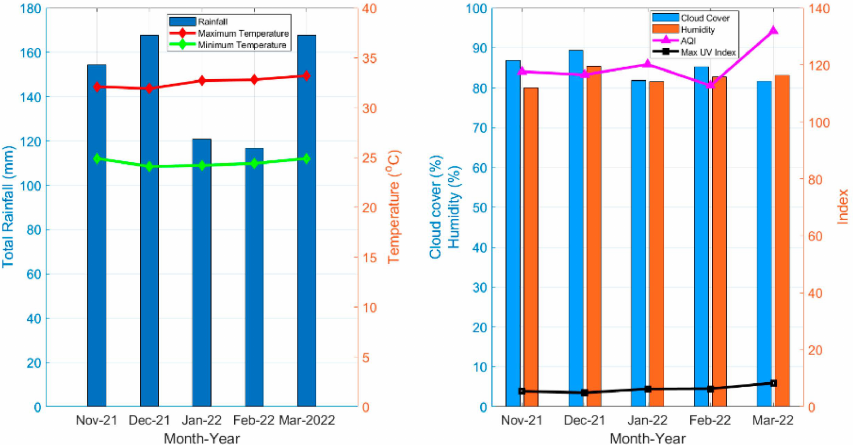
Figure 3. Meteorological data collected from 21 November to 22 March 2022 at Petaling Jaya, Selangor,